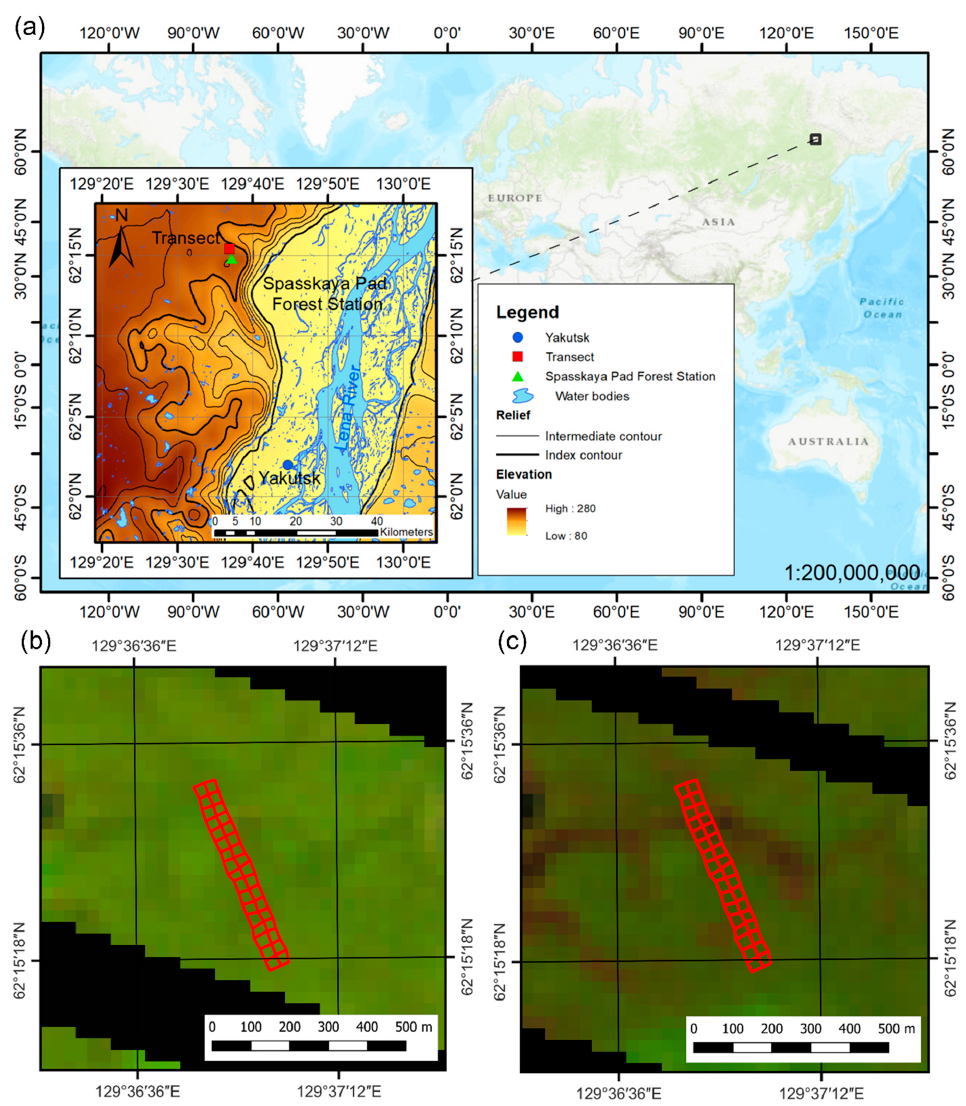
Figure 1. Location of the Spasskaya Pad Station (62°25 ′ N, 129°62 ′ E) and the study transect near Yakutsk in the topographical map zoomed from a global map ( a ). The study transects 60 m × 510 m in Landsat 7 ETM+ Natural Color Images with a spatial resolution of 30 m before the wet event on 11 June 2006 ( b ) and after the wet event on 9 June 2008 ( c ). The red polygons represent the 34 plots. The black stripes in the last two figures represent the Landsat 7 scan-line error (no data). Figure 1b,c shows the vegetation cover (Landsat 7 ETM+ Natural Color Images) 1 km north of the Spasskaya Pad Forest Station before (2006) and after (2008) the extreme wet event, respectively. In order to investigate the long-term effect of the extreme wet event on the forest, in the summer of 2018 (a decade after the event), a 60 m × 510 m transect was set up using wooden pegs and plastic strings, in both intact and affected areas. The tran- sect was divided into 30 m × 30 m plots (in total, 34 plots, red polygons in Figure 1b,c) and these were visually classified based on the forest conditions from the photographs. Four